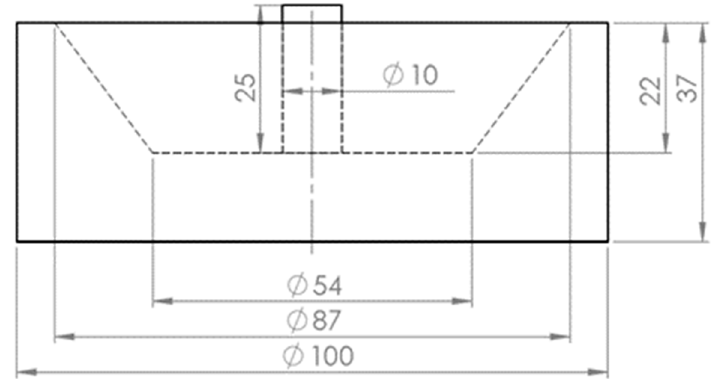
Figure 2. Drawing of the steel crucible, dimensions are in mm.